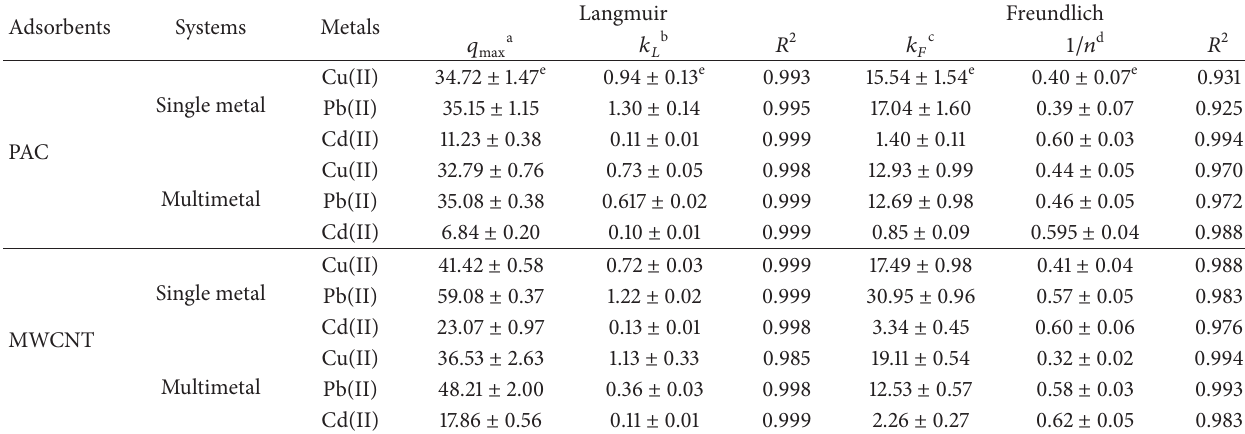
Table 3: Isotherm model parameters of the metal adsorption on PAC and MWCNT at pH 7.0.